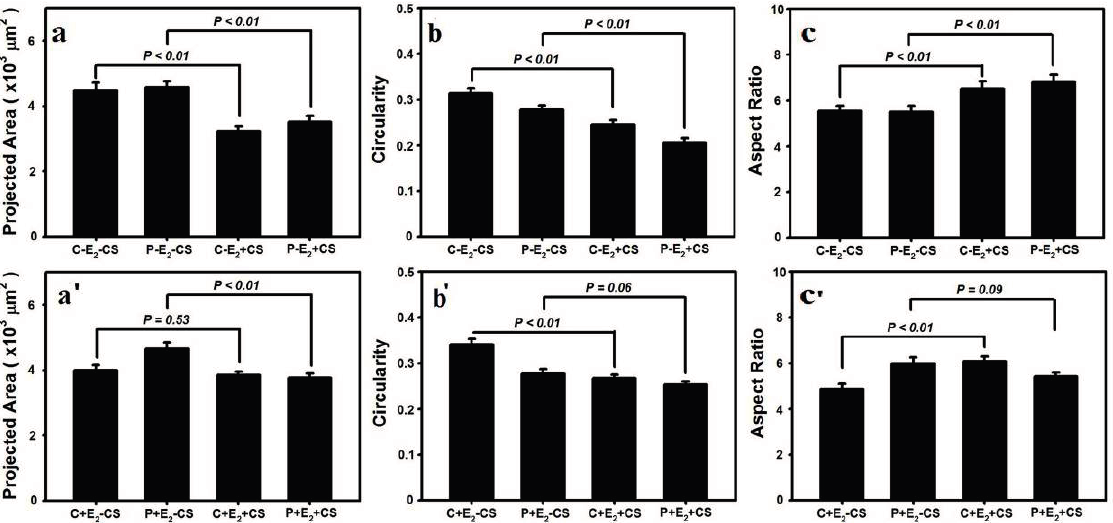
Figure 3. Effects of CS and 17- β -estradiol (E 2 ) on the vaginal fibroblast projection area, triplicate